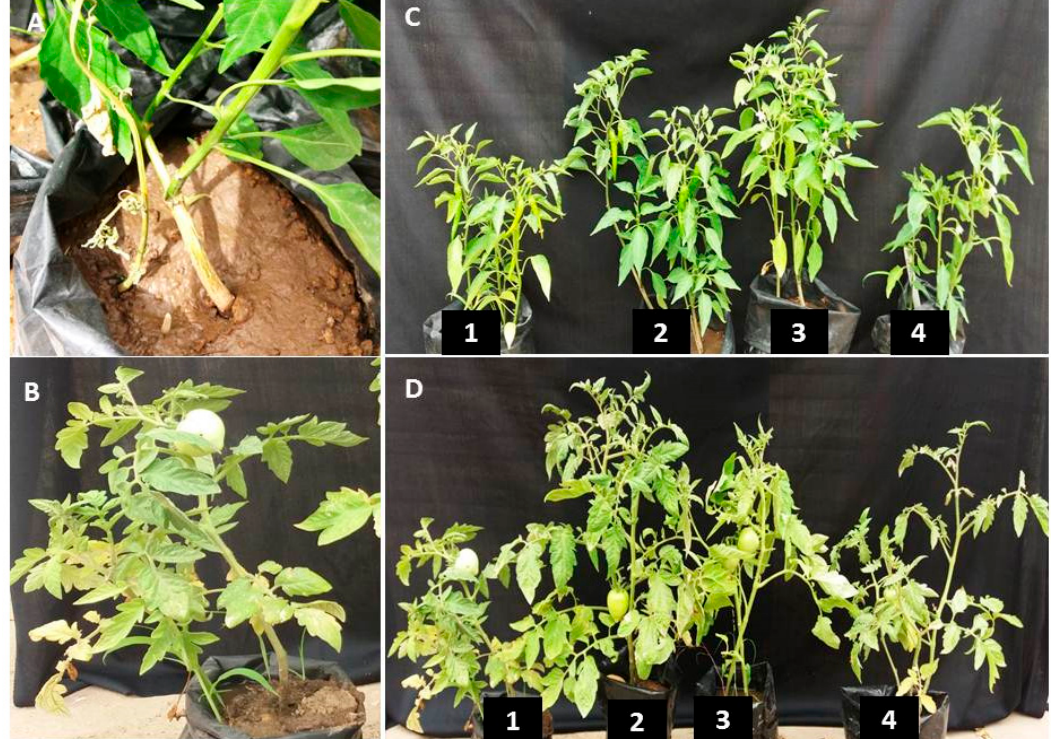
Figure 8. In vivo treatments of tomato and pepper plants with rGO-CuO NPs. ( A ) Pepper plant showing Fusarium wilt symptoms. ( B ) Infected control of tomato plant. ( C , D ) Pepper ( C ) and tomato ( D ) plants non-treated ( 1 ) or treated with 1 mg / L ( 2 ) or 100 mg / L rGO-CuO NPs ( 3 ), or treated with Kocide ( 4 ). Pictures were taken at 60 dpi.